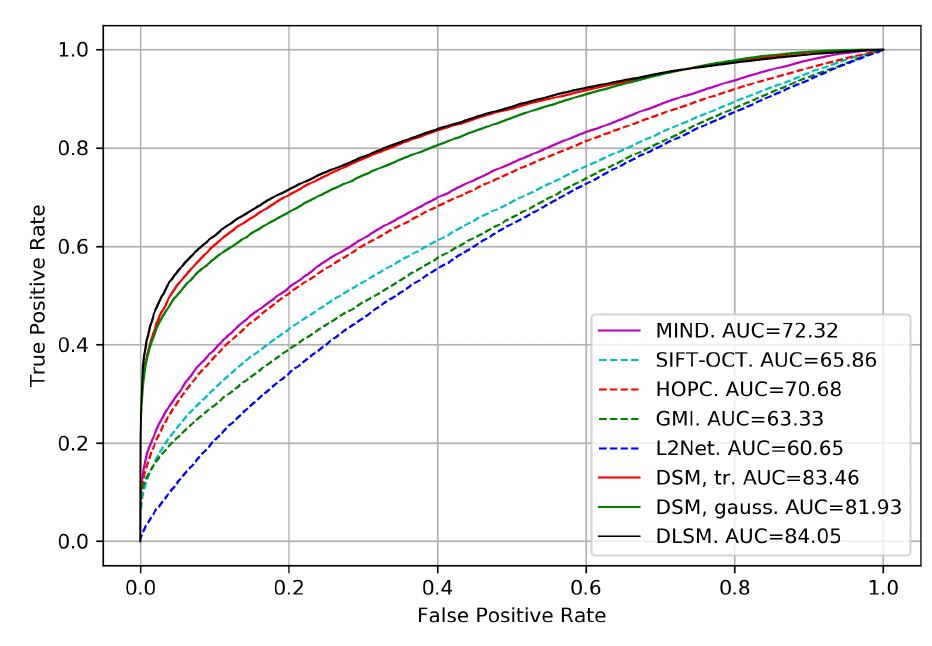
Figure 6. Receiver Operating Characteristic (ROC) curves for the proposed DLSM and existing SMs for the general registration